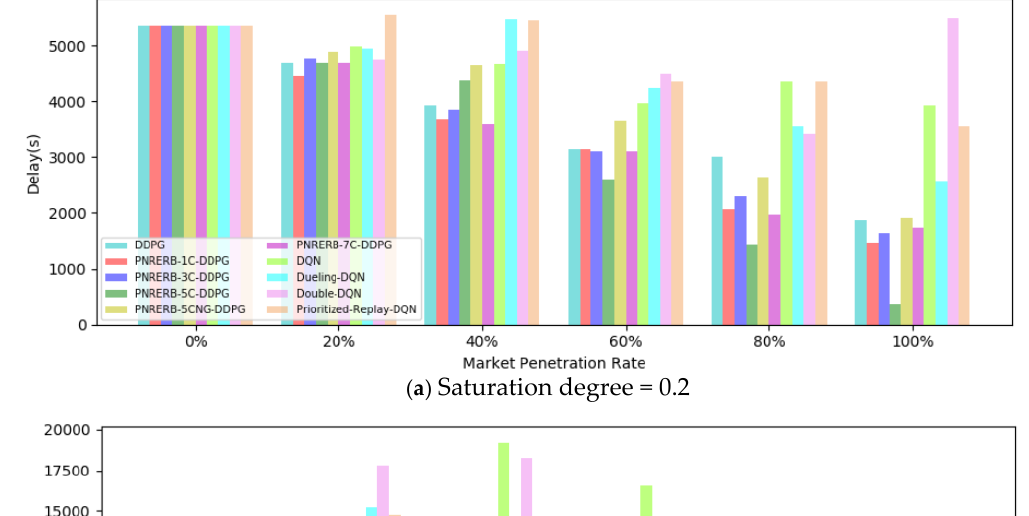
Table 6. Total fuel consumption (TFC) and total exhaust emission (TEE) values under saturation degrees of 0.2/0.5/0.7.